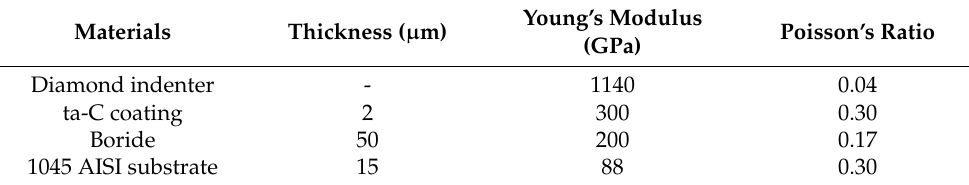
Table 2. Material properties used in the FEA